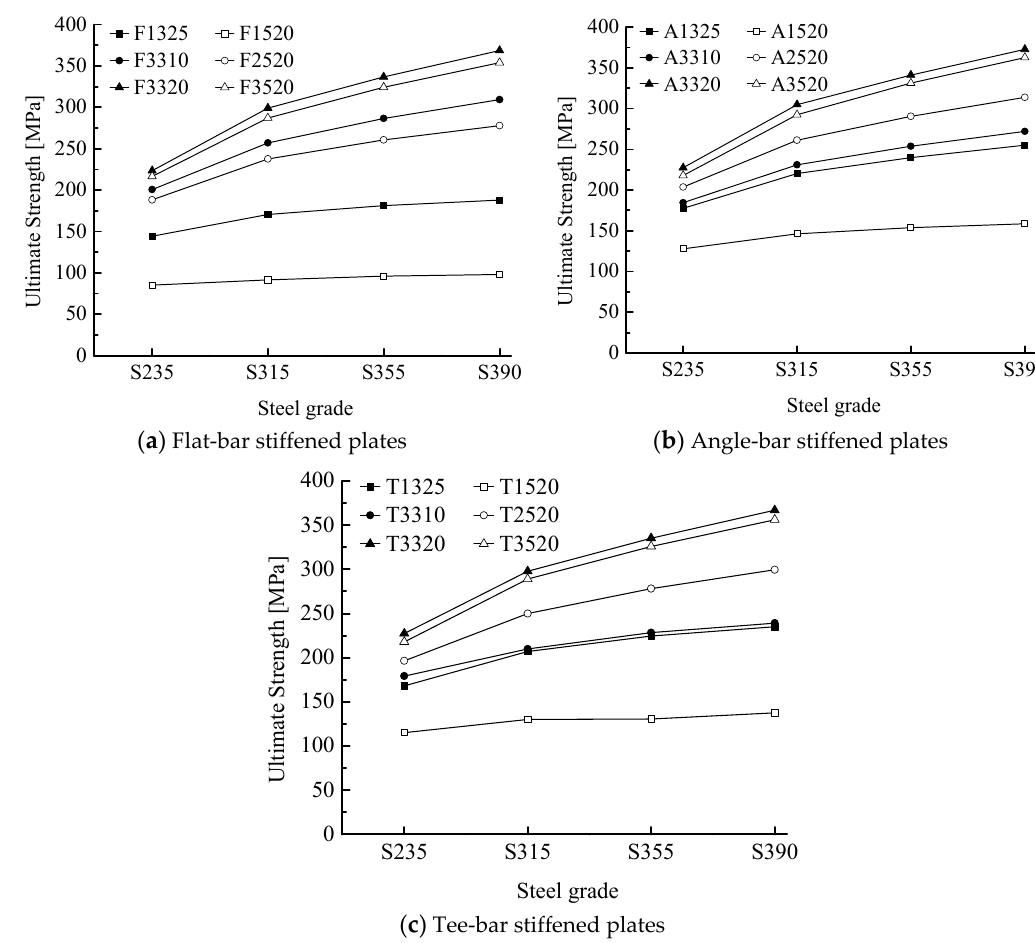
Figure 11. The trend of ultimate strength of the stiffened plates with various built-up steels.